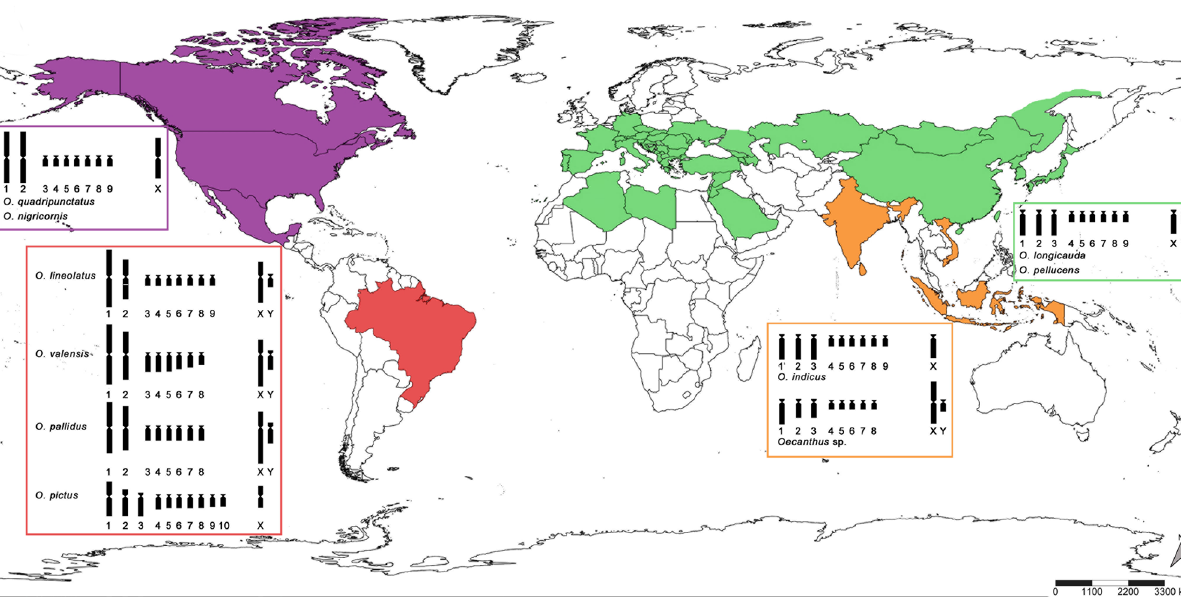
Figure 5 – Map showing the distribution of Oecanthus species with karyotypes analyzed. In green, O. longicauda and O. pellucens from the Palearctic bioregion, both with 2n = 20, XY♂ (Hewitt 1979; Ohmachi 1927; Makino 1932). In purple, O. nigricornis and O. quadripunctatus from the Nearctic bioregion, both with 2n = 19, X0♂ (Johnson 1931; Beaudry 1973). In orange, species from the Oriental bioregion, O. indicus with 2n = 19, X0♂, and Oecanthus sp. with 2n = 18, XY♂ (Kitada 1949; Nakamura and Kitada 1955; Aswanianarayana and Ashwath 2005). In red, species from the Neotropical bioregion, O. lineolatus with 2n = 20, XY♂; O. valensis and O. pallidus with 2n = 18, XY♂; and O. pictus with 2n = 21,